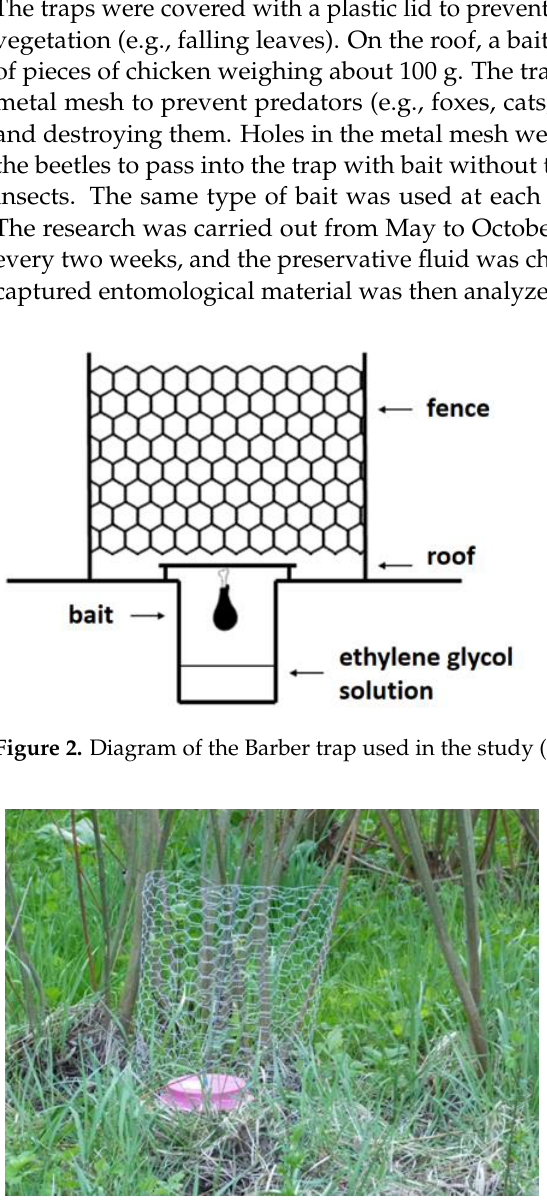
Figure 3. The Barber trap used in osier plantation Salix viminalis (authors).